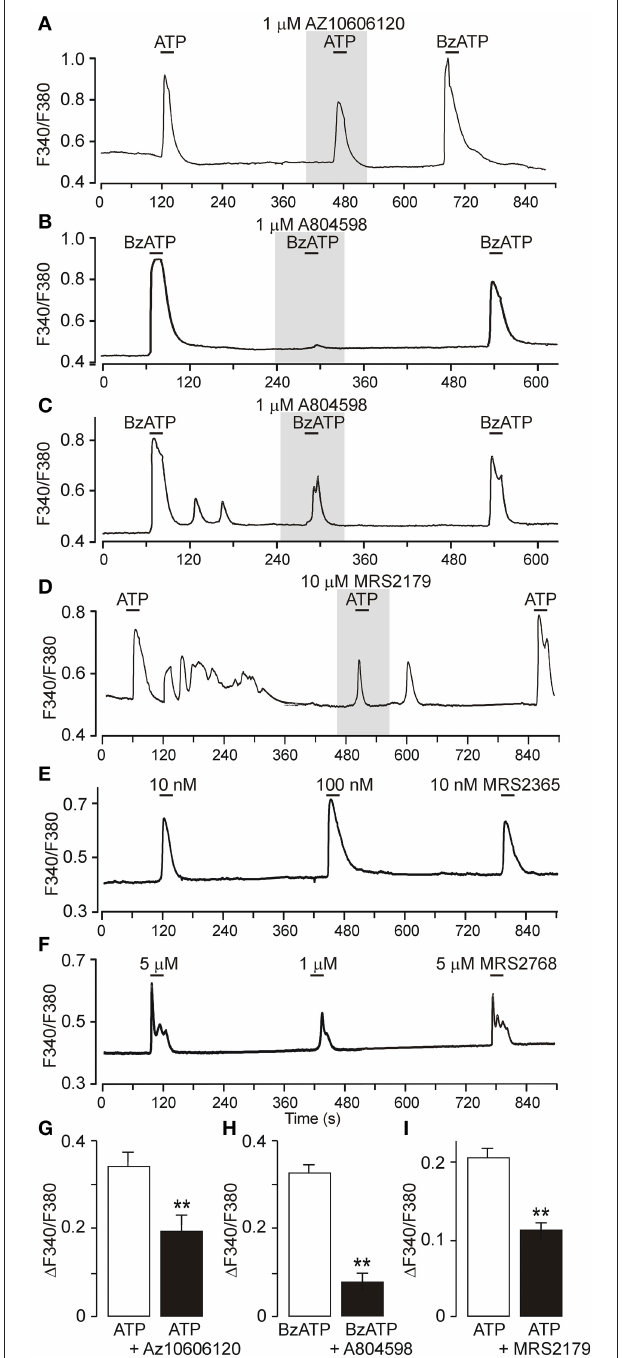
FIGURE 6 | Calcium signaling mediated by P2X7R and P2Y1R in primary cultures of SCN astrocytes. (A) Increases in intracellular calcium in cultured SCN astrocytes in response to ATP and BzATP (both 50 µ M) and partial inhibition of the ATP-induced [Ca 2 + ] i increase by the P2X7R blocker AZ 10606120. The ratio of light intensity (F 340 /F 380 ) reflects changes in intracellular calcium concentration ([Ca 2 + ] i ). (B,C) BzATP-induced [Ca 2 + ] i increases completely (B) or partially (C) inhibited by the P2X7R blocker A438079. (D) Inhibition of ATP-induced responses in the presence of